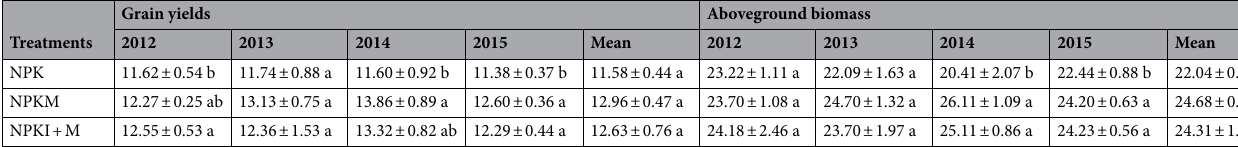
Table 1. Maize grain yields and aboveground biomass from 2012 to 2015 (Mg ha −1 ). Different lowercase letters indicate significant differences (p < 0.05). “with” the same letters were not significantly different (p > 0.05).